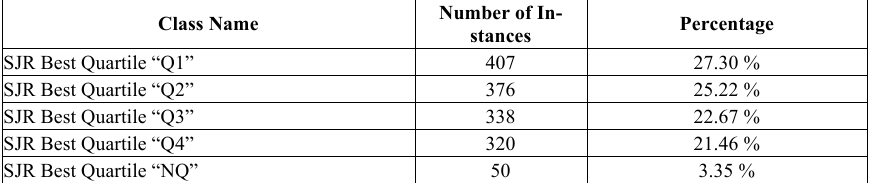
Table 3. Proportion of dataset class members